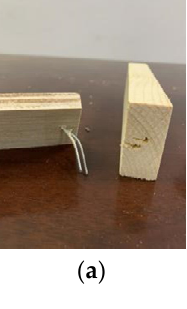
Figure 7. Wood joint failure mode: ( a ) staple legs are pulled out; ( b ) staple legs are pulled out; ( c ) cracked pine wood; ( d ) cracked front end of pine wood; and ( e ) broken plywood.